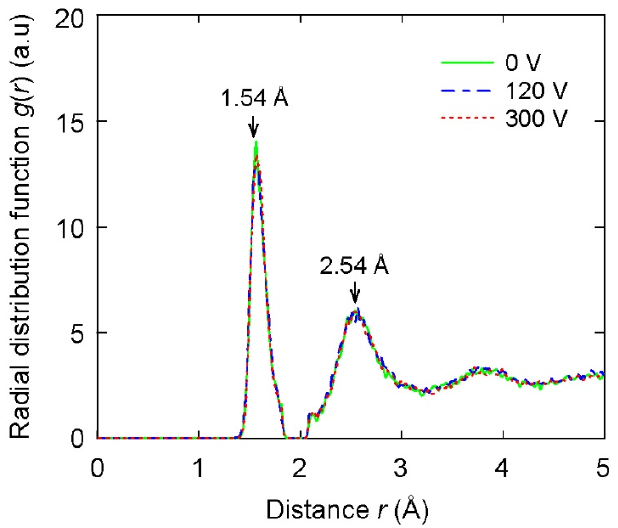
Figure 4. The radial distribution function of the DLC films according to different substrate voltage values.